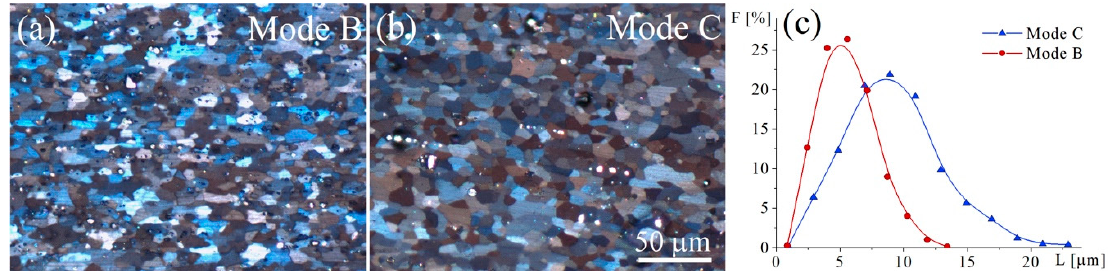
Figure 6. Grain structures after annealing at 500 °C for 30 min: ( a ) mode B, ( b ) mode C, ( c ) grain size distributions. Table 2. Mean grain size after recrystallization annealing of the sheets at 500 °C for 30 min.